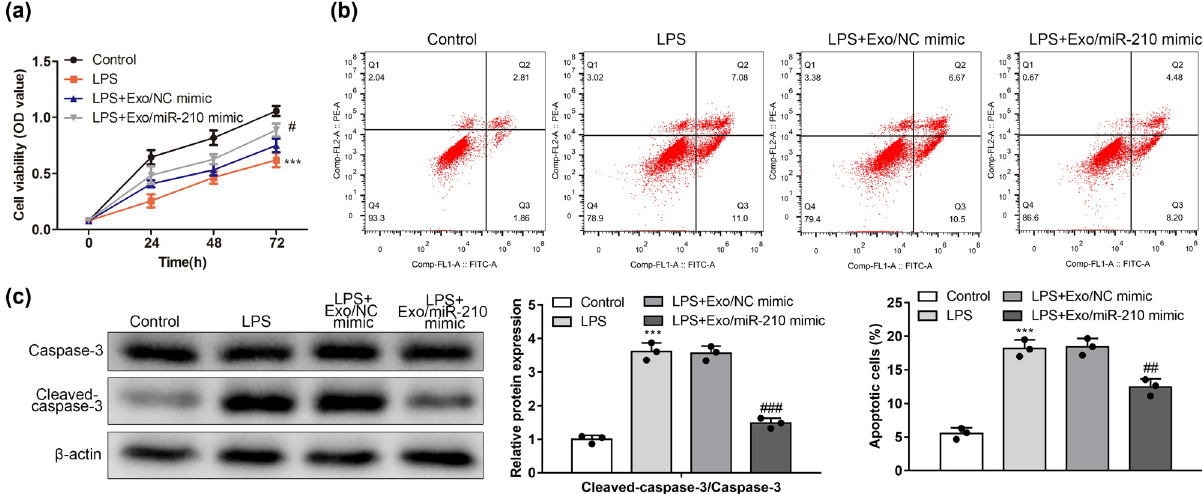
Figure 5: Exosomal miR - 210 inhibited microglia - mediated neuroin fl ammation and reduced neuronal apoptosis. ( a ) Viability of neuronal HT22 cells was assessed using the CCK ‐ 8 method. ( b ) Percentage of apoptotic neuronal HT22 cells was assessed using fl ow cytometry ( n = 3 ) . ( c ) Representative immunoblots were probed with antibodies against Cleaved ‐ caspase - 3, caspase - 3, and β ‐ actin ( n = 3 ) . Quanti fi cation of the level of Cleaved ‐ caspase - 3 normalized to β ‐ actin. Quanti fi cation of the level of caspase - 3 normalized to β ‐ actin. *** P < 0.001 vs Control; #P < 0.05, ## P < 0.01, ### P < 0.001 vs LPS + Exo/NC